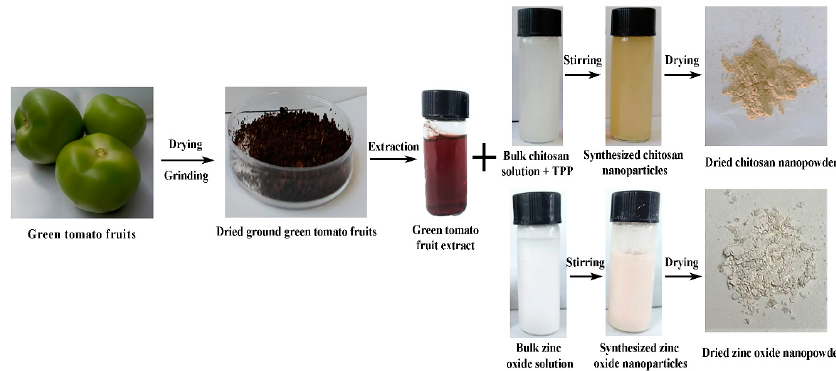
Figure 1. Schematic presentation of the preparation of chitosan nanoparticles (CSNPs) and zinc oxide nanoparticles (ZnONPs).